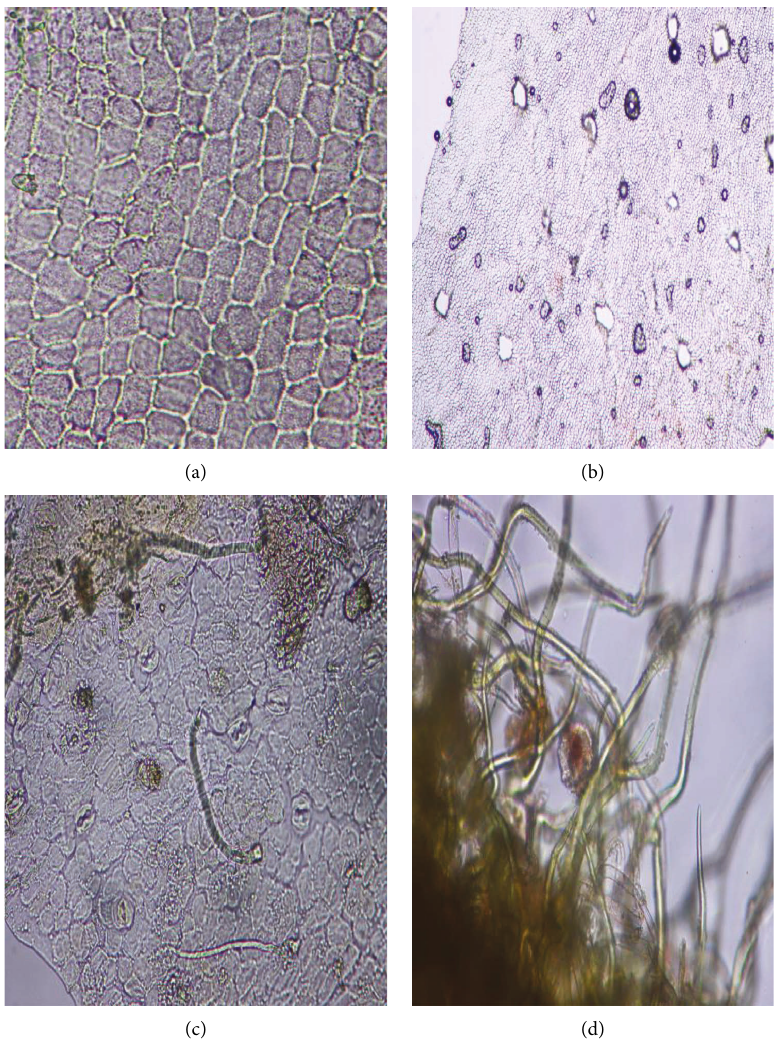
Figure 4: Microscopic characteristics of buds: (a) buds’ sepals epiderma (magn. × 400); (b) buds’ receptacle adaxial epiderma (magn. × 100); (c) buds’ receptacle adaxial epiderma (magn. × 400); (d) buds’ receptacle abaxial epiderma with trichomes and pollen (magn. ×